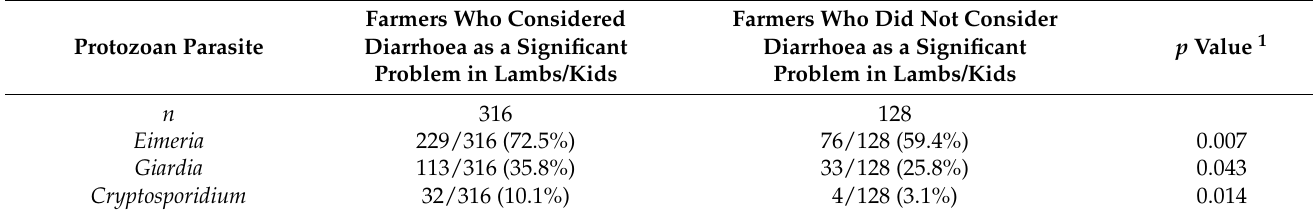
Table 7. Proportion of farms with recovery of protozoan parasites from the faecal samples of animals, as found during a countrywide investigation (April 2019 to July 2020) in Greece, in accordance with the farmers’ perception of the significance of diarrhoea as a problem in lambs or kids on their farms. Farmers Who Did Not Consider Farmers Who Considered Diarrhoea as a Significant Protozoan Parasite Diarrhoea as a Significant p Value 1 Problem in Lambs/Kids Problem in Lambs/Kids n 316 128 Eimeria 229/316 (72.5%) 76/128 (59.4%) 0.007 Giardia 113/316 (35.8%) 33/128 (25.8%) 0.043 Cryptosporidium 32/316